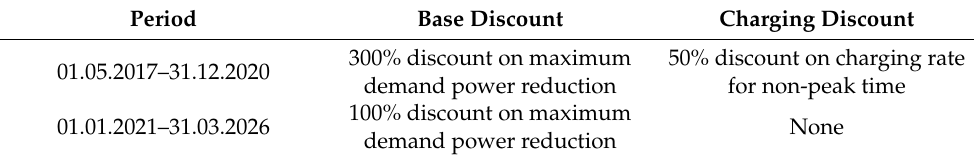
Table 5. ESS electricity charge discount plan